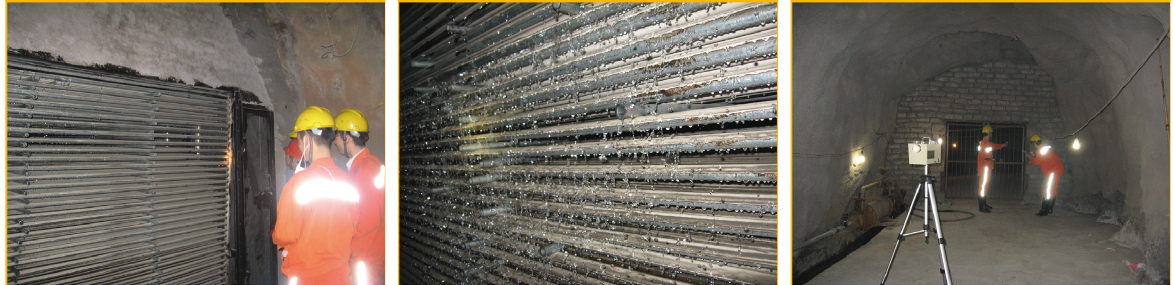
Figure 5: Photos of dust collector in underground metal